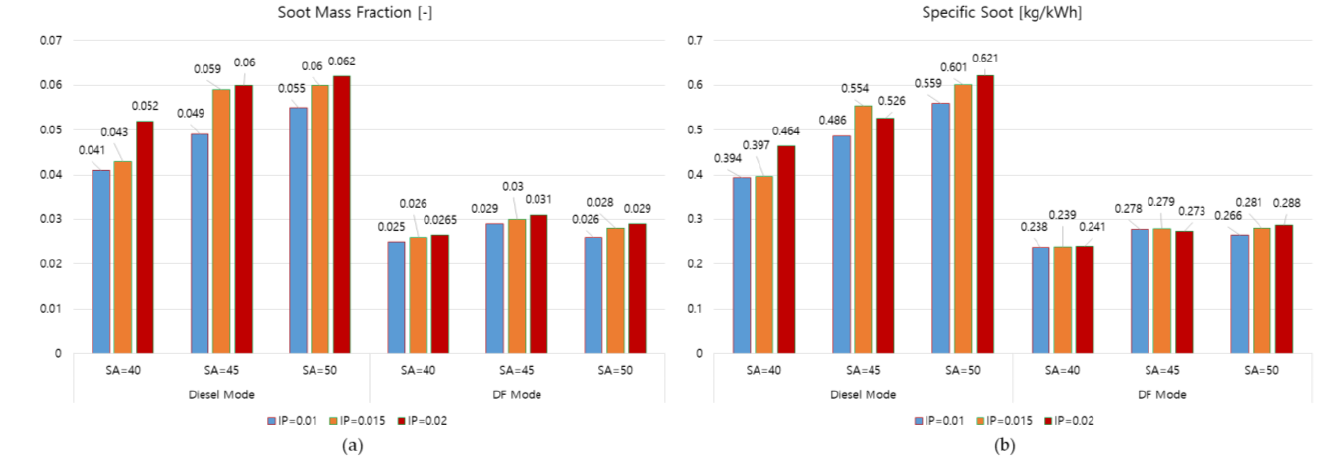
Figure 15. Soot emissions in all simulation cases: ( a ) soot mass fraction, ( b ) specific soot.